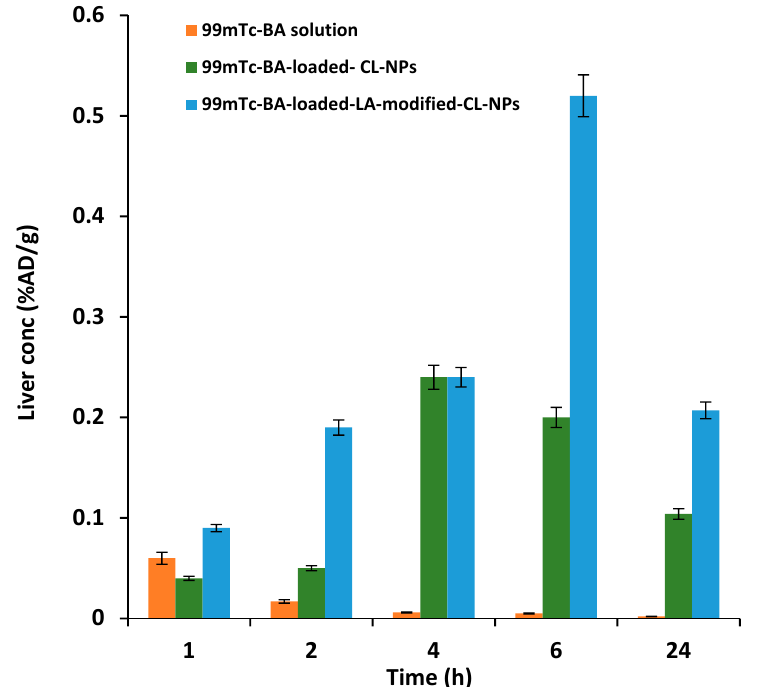
Figure 8. Mean ( ± SD) BA concentration in liver following oral administration of radiolabeled 99m Tc-BA to mice.